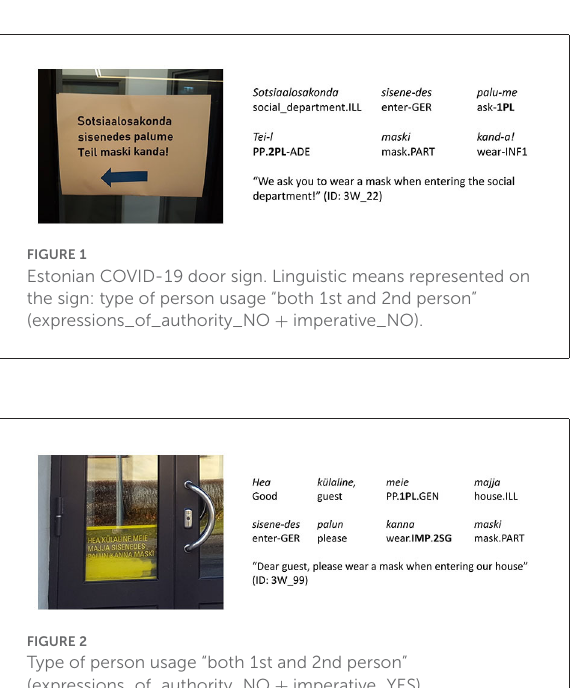
FIGURE2 Type of person usage “both 1st and 2nd person” (expressions_of_authority_NO +